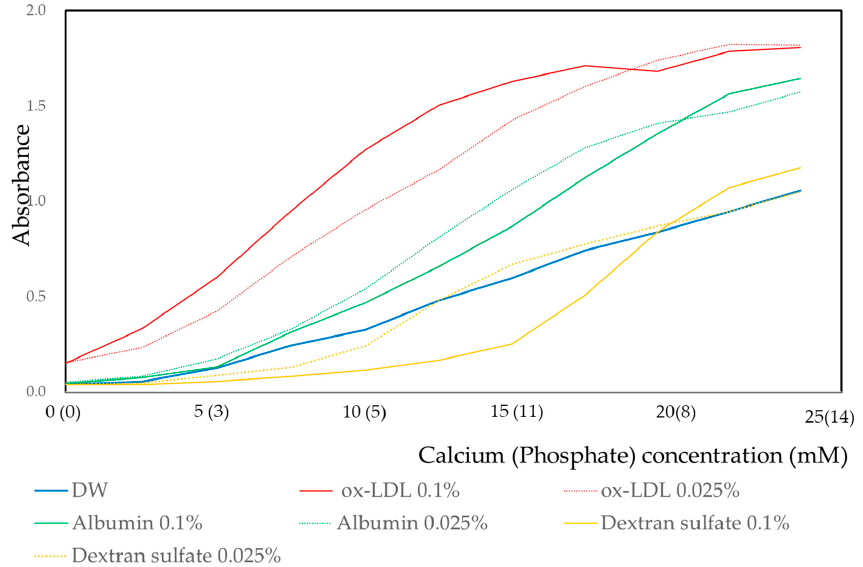
Figure 3. Effect of the concentration of biomaterials on the calcium and phosphate reaction. Absorbance values were measured at a wavelength of 650 nm.